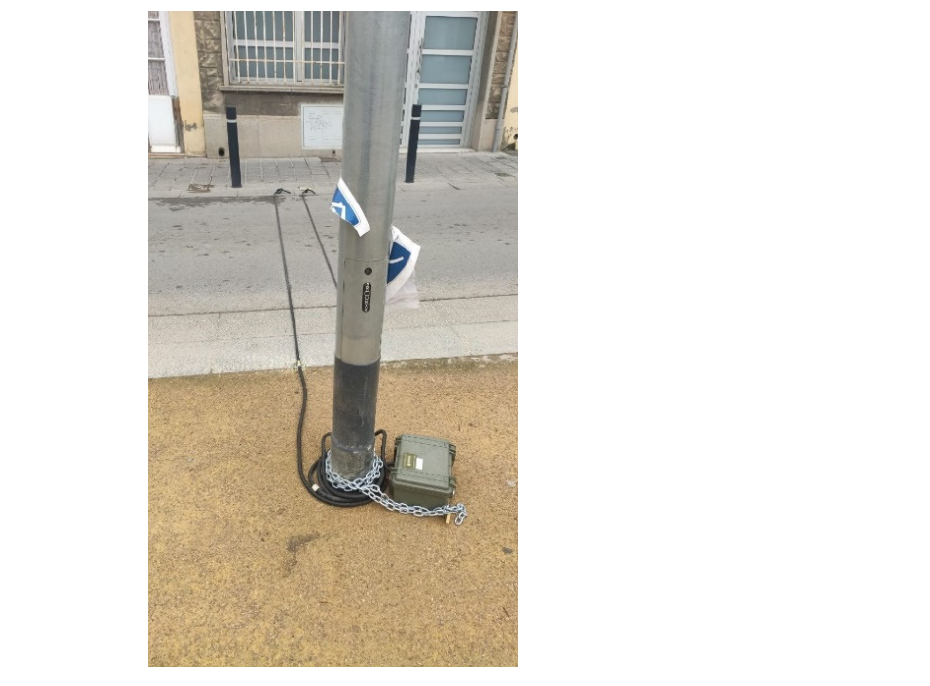
Figure 8. Circulation counting mechanical sensor (photo by author) located at M2 according to Figure 6.